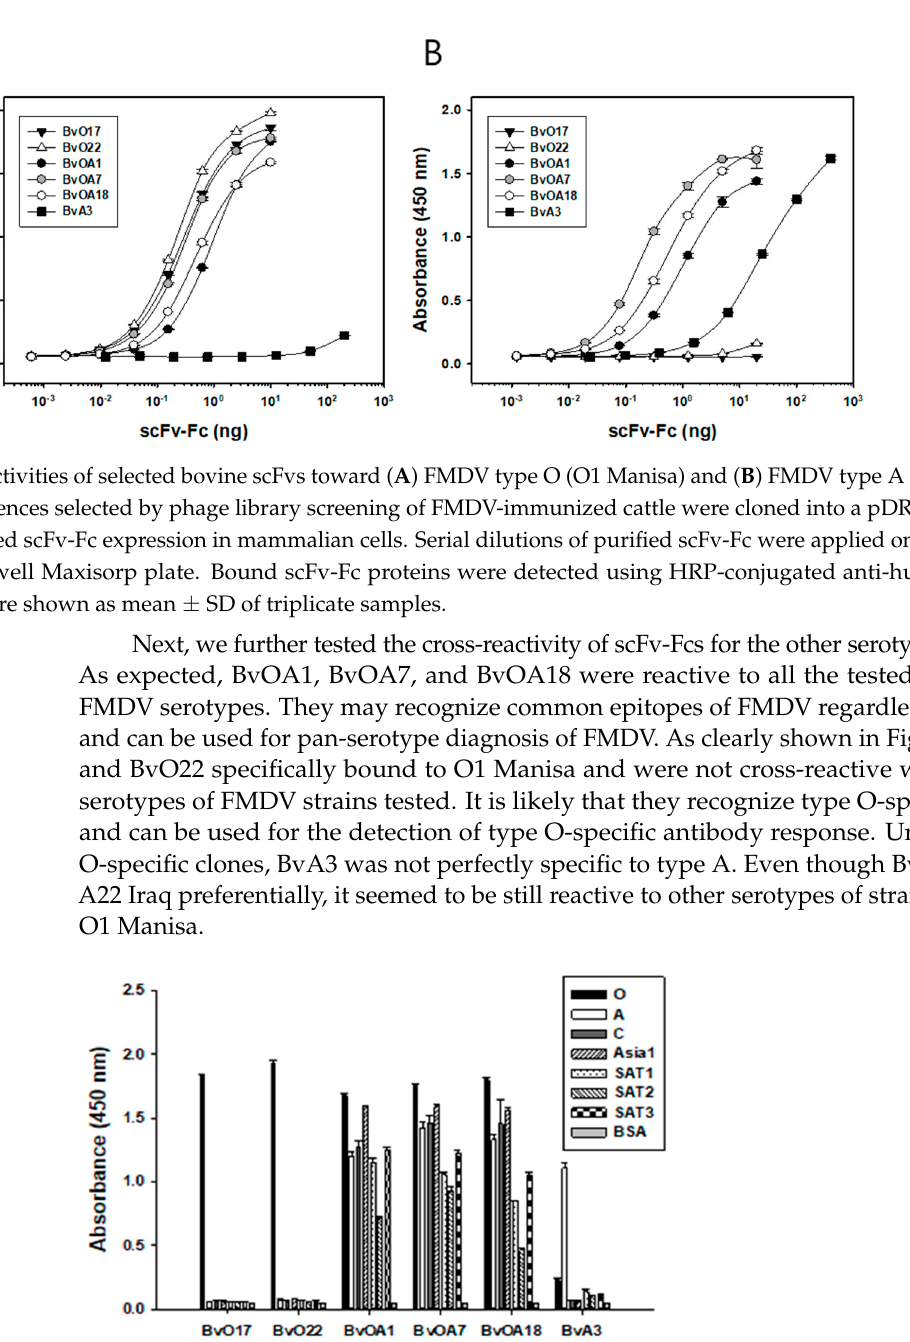
Figure 2. Cross-reactivities of bovine scFvs to seven serotypes of FMDV. Inactivated FMDV